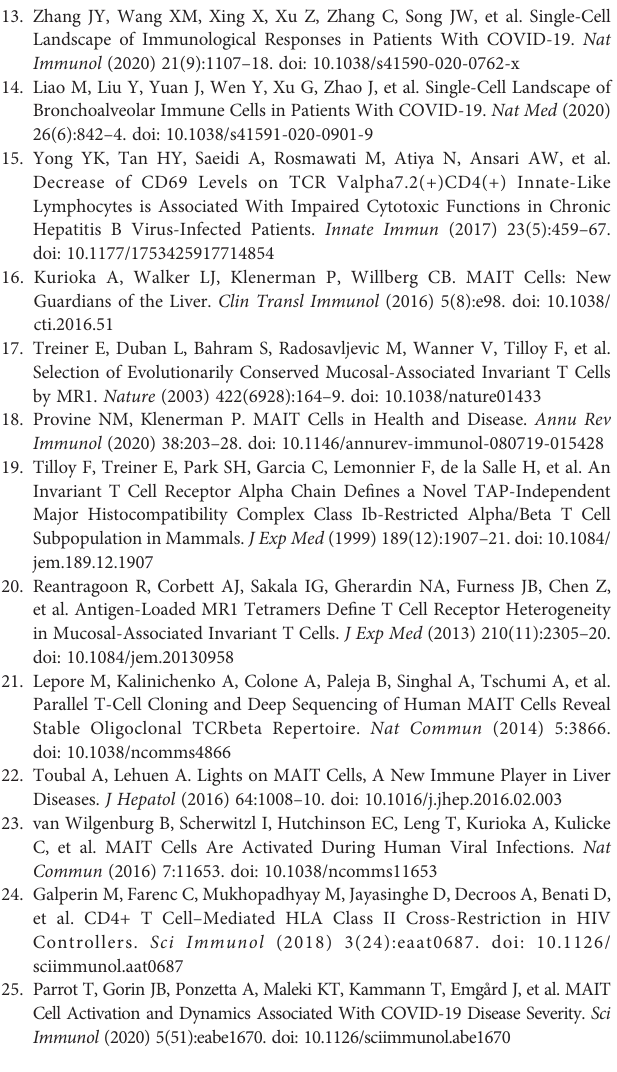
Supplementary Figure 1 | Quality of clustering and annotation of MAIT cells. (A) MAIT cell annotation and UMAP projection of integrated single-cell